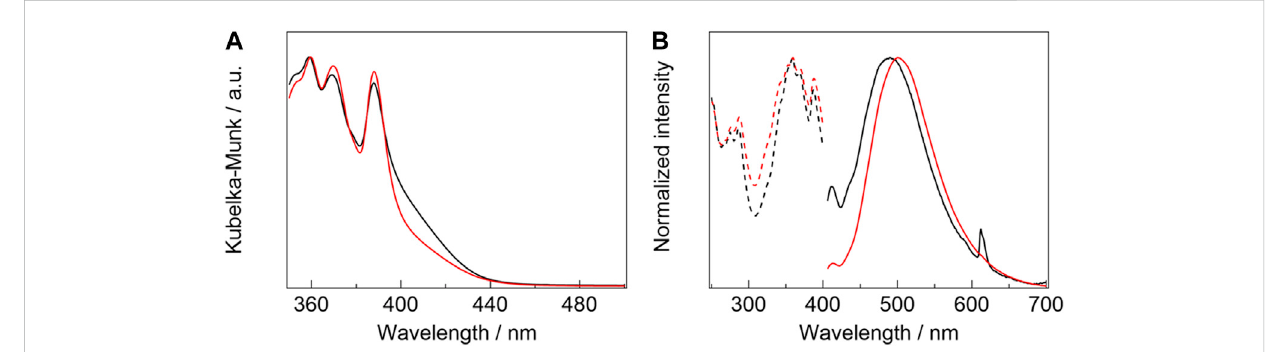
FIGURE 4 (A) Diffuse-absorption spectra of [Eu 2 (hfa) 6 (PDDPO) 2 ] (black line) and [Gd 2 (hfa) 6 (PDDPO) 2 ] (red line). (B) Emission (solid line, λ ex = 325 nm) and excitation spectra (broken line, λ em = 510 nm) of [Eu 2 (hfa) 6 (PDDPO) 2 ] (black line) and [Gd 2 (hfa) 6 (PDDPO) 2 ] (red line).